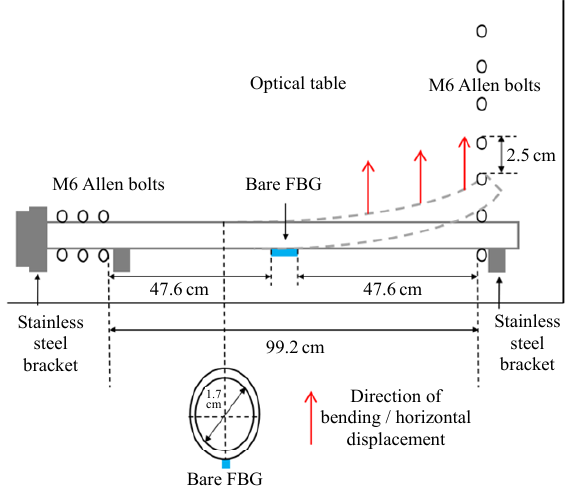
Fig. 3 Experimental setup for the bare and embedded FBG-based strain sensor